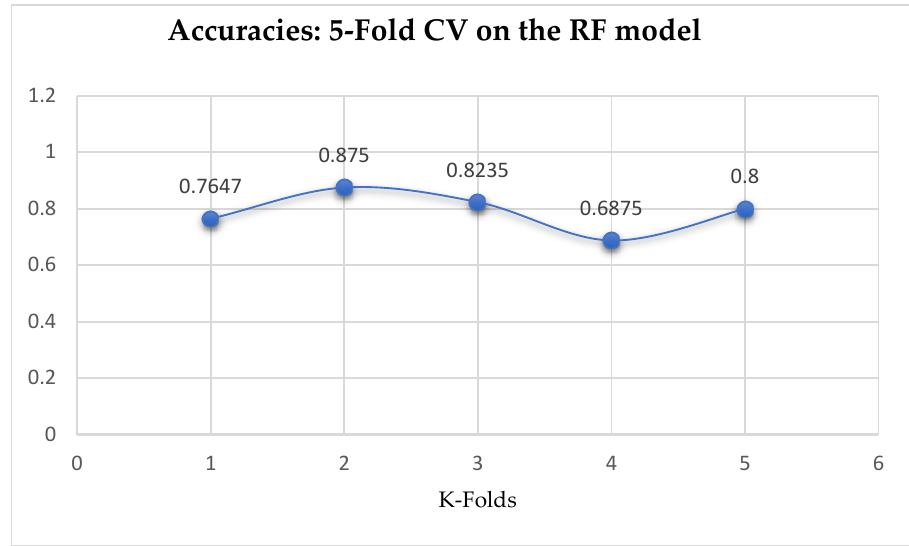
Figure 17. The accuracies achieved by the Folds after performing 5-Fold Cross-Validation on the RF model. Appl. Sci. 2019 , 9 , x FOR PEER REVIEW